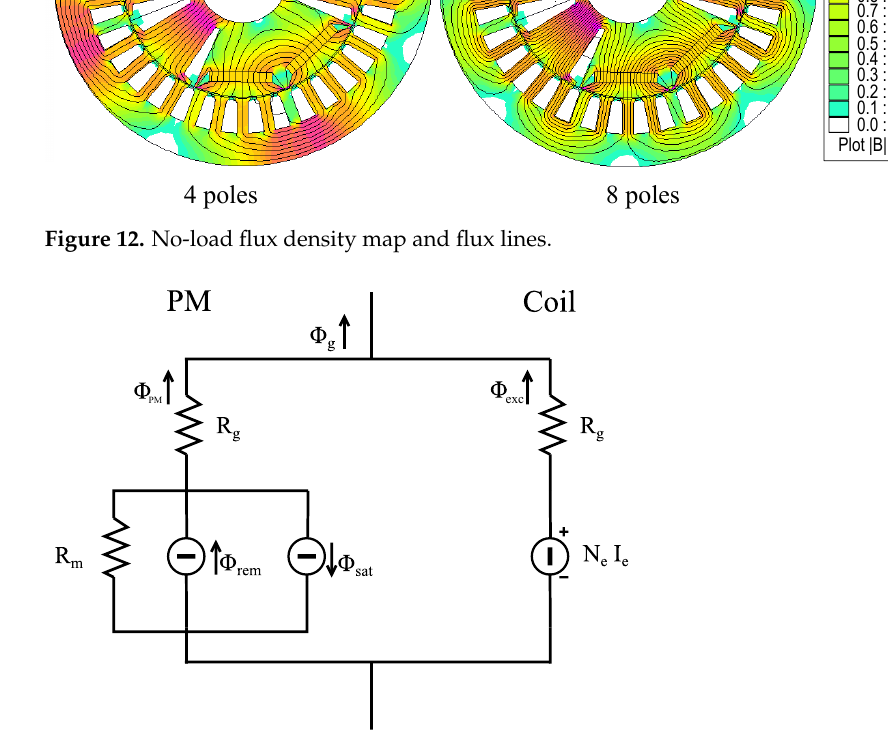
Figure 11. Magnetic equivalent circuit of the hybrid excitation. Figure 13. No-load flux density waveform along the air